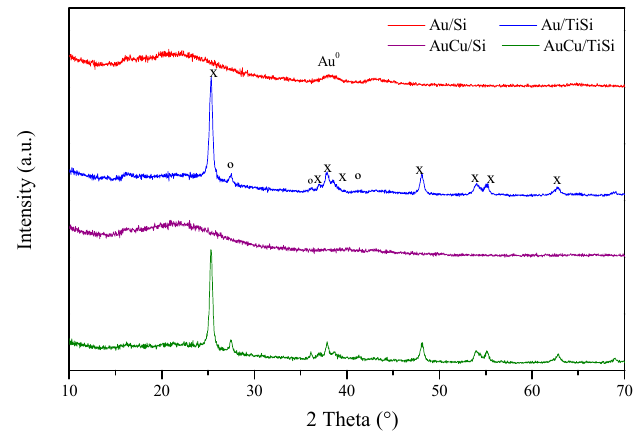
Figure 5. Wide angle X-ray diffractograms of the studied photocatalysts (x: anatase; °: rutile).